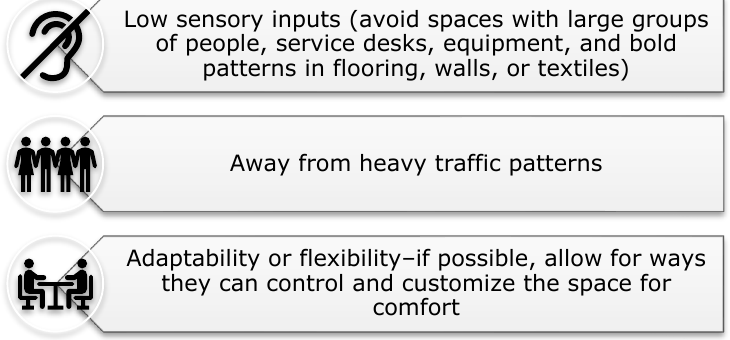
What to Look for in a Space for Autistic Students